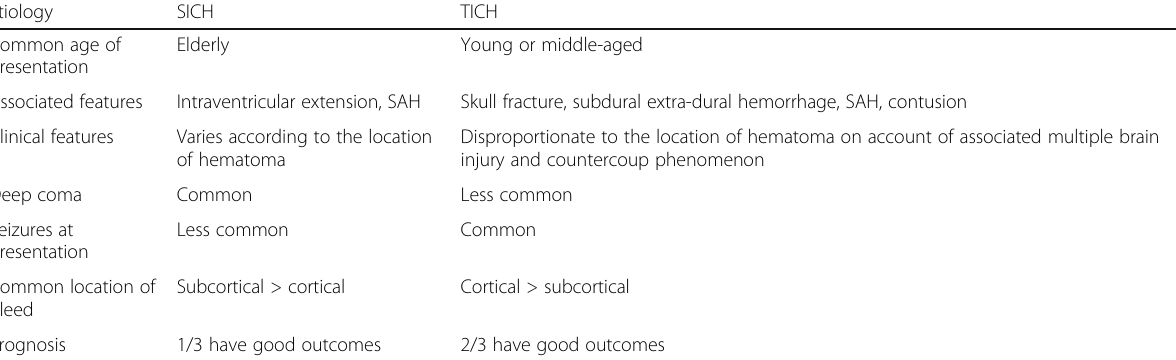
Table 2 Differences between spontaneous and traumatic SAH [12] Etiology SICH TICH Common age of Elderly Young or middle-aged presentation Associated features Clinical